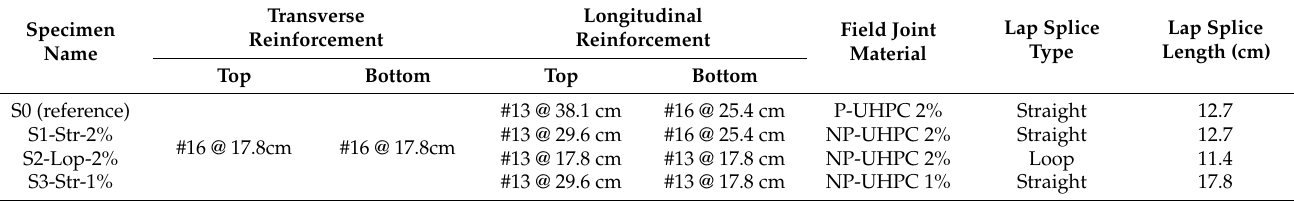
Table 4. Experimental Test Matrix and Specimen Design